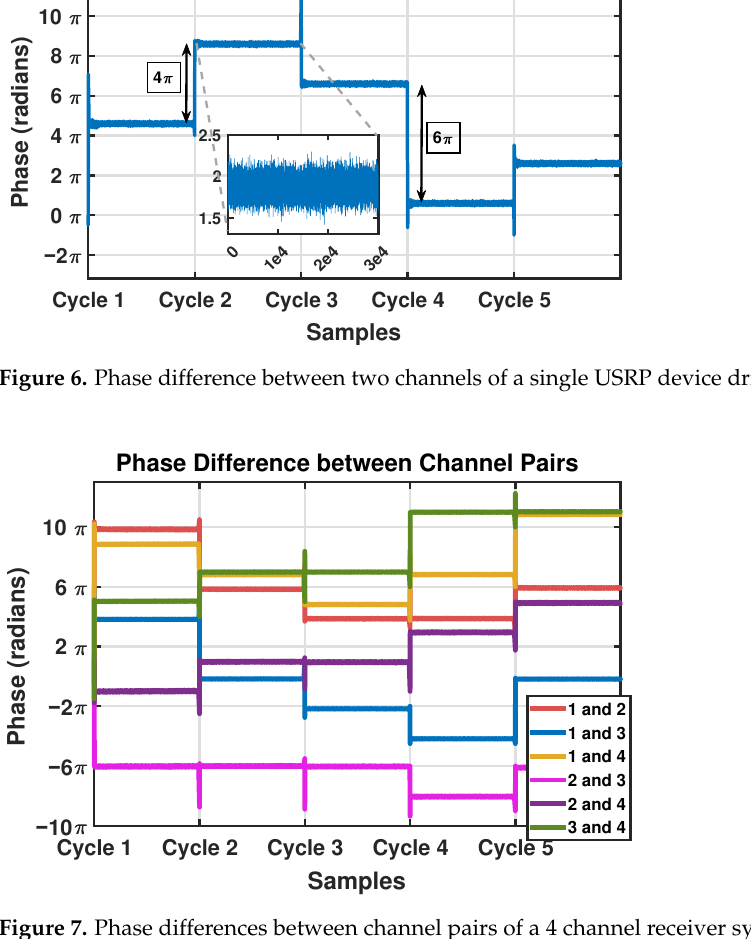
Figure 7. Phase differences between channel pairs of a 4 channel receiver system using two USRPs (2 channels each) sharing a 10 MHz clock and PPS